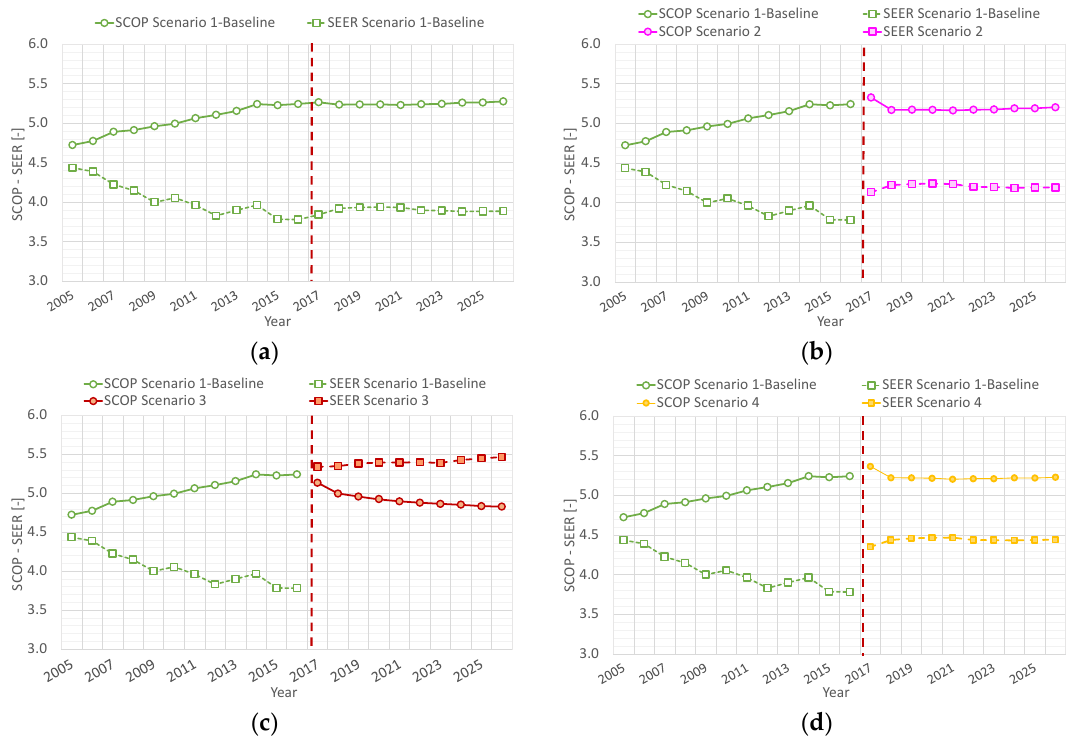
Figure 9. Seasonal energy efficiency of the heat pump: simulated values in ( a ) Scenario 1 , ( b ) Scenario 2 , ( c ) Scenario 3 , ( d ) Scenario 4 .